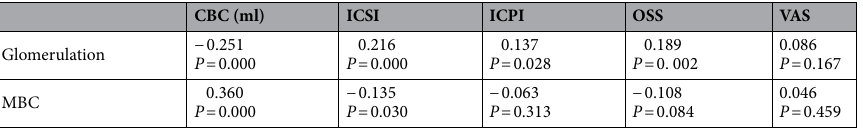
Table 1. Pearson correlation coefficients for correlations between glomerulation grade or maximal bladder capacity and interstitial cystitis symptom score parameters. MBC, maximal bladder capacity; CBC, cystometric bladder capacity; ICSI, Interstitial Cystitis Symptom Index; ICPI, Interstitial Cystitis Problem Index; OSS, O’Leary–Sant Symptom score; VAS, visual analog scale score.